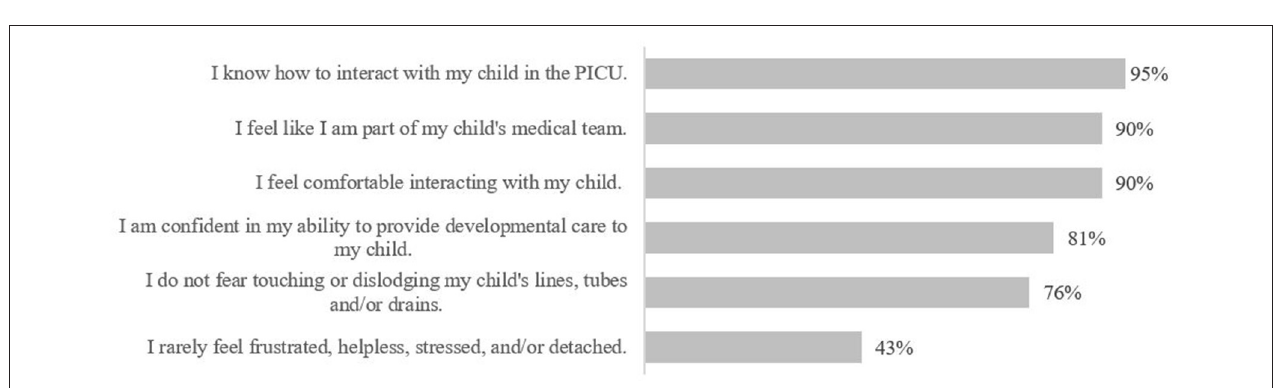
FIGURE 8 | Family level of agreement on PICU experience statements (volunteer, pre-survey).